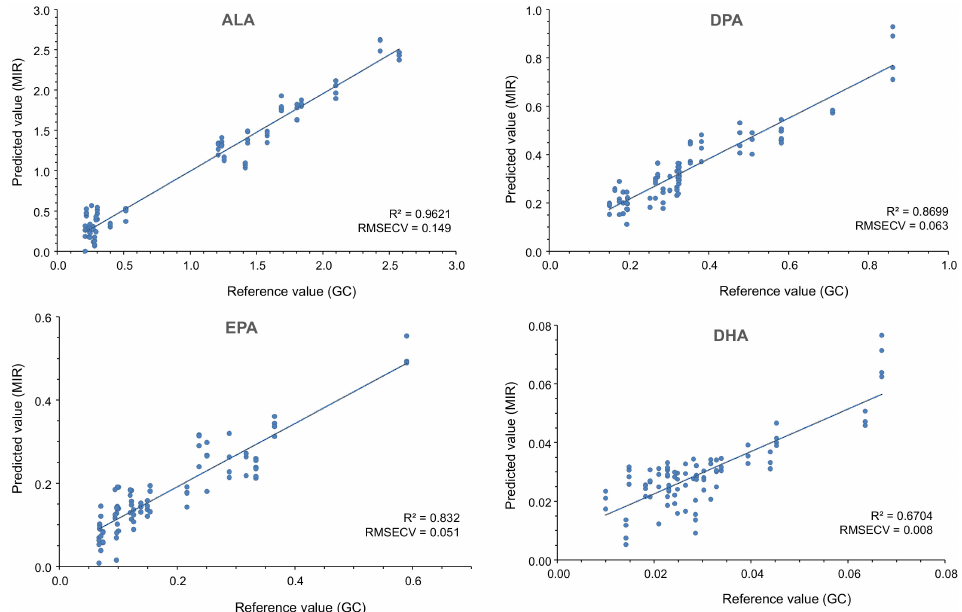
Figure 5. Scatter plot showing the relationship between the reference value, as determined by gas chromatography, and the predicted value in α -linolenic acid (ALA), docosapentaenoic acid (DPA), eicosapentaenoic acid (EPA), and docosahexaenoic acid (DHA) contents by MIR spectroscopy; R 2 = coefficient of determination. RMSECV = root mean square error of cross-validation.